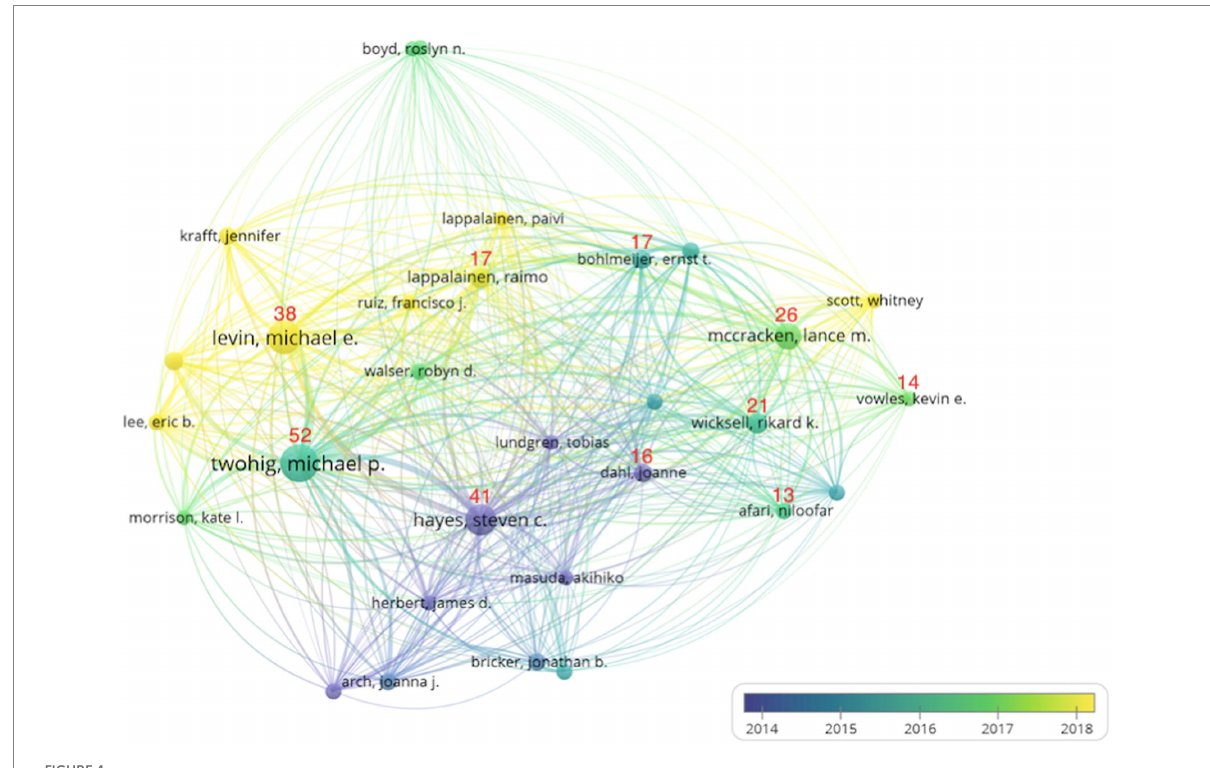
FIGURE 4 The overlay map of authors (top